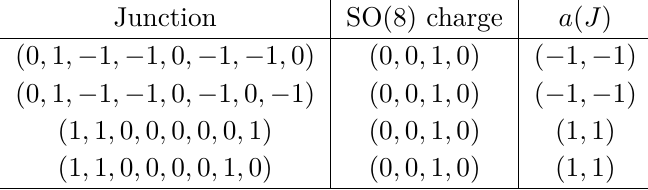
Table 5 . The four junctions with highest weight of 8 s under SO(8)